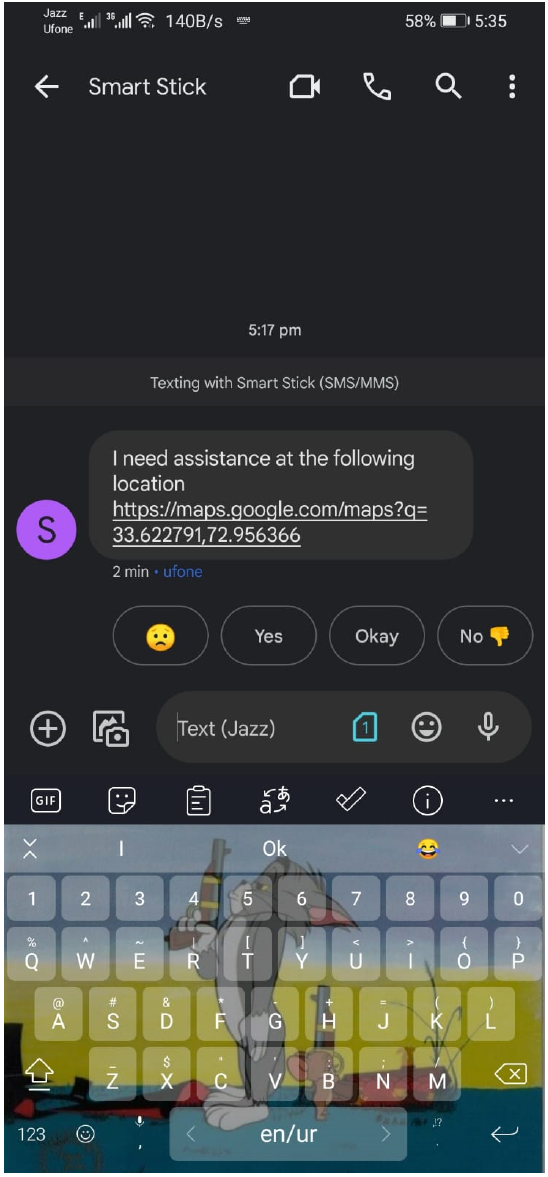
Figure 11. Location sharing SMS through GSM.